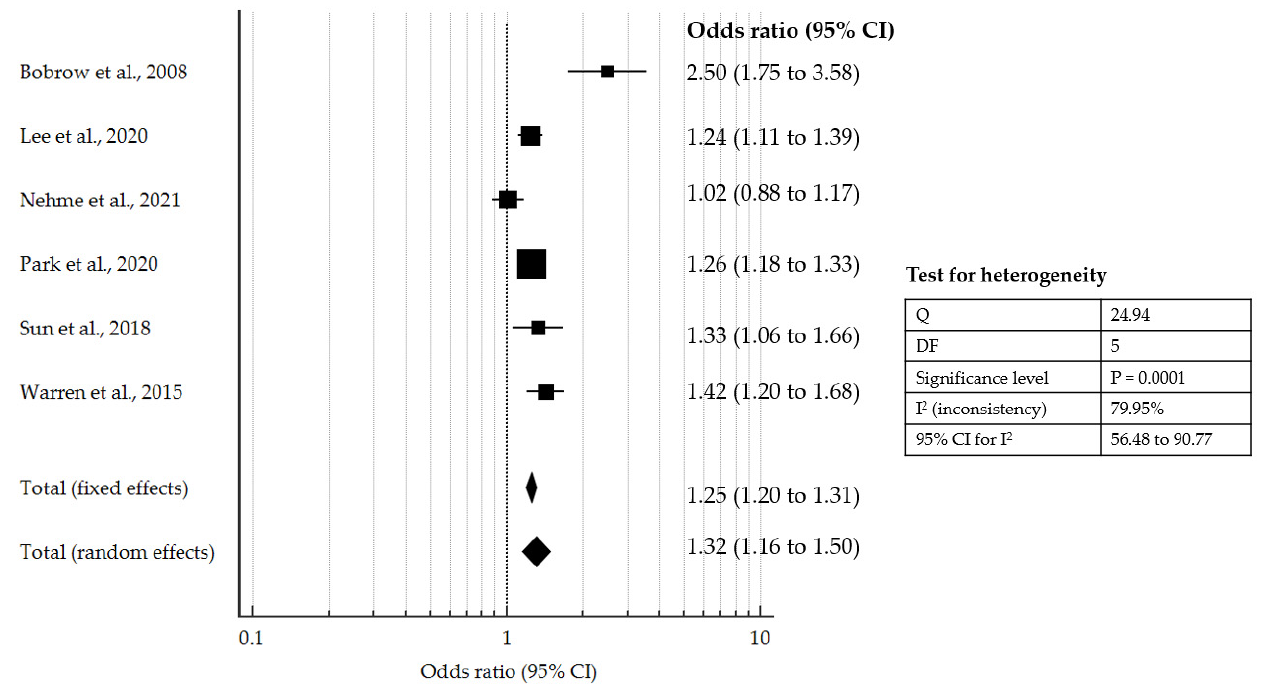
Figure 2. Forest plot showing pooled OR for survival-to-discharge with HP CPR or similar intervention compared to controls.